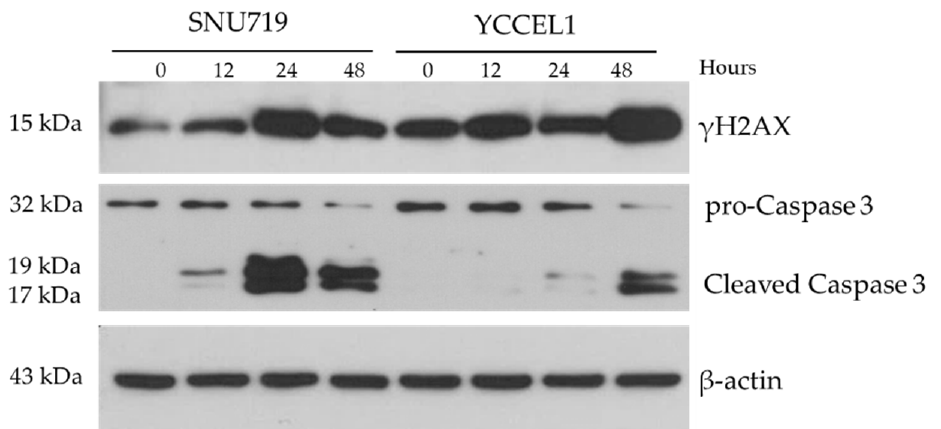
Figure 4. Protein Expression of γ H2A histone family member X ( γ H2AX) and caspase-3 after MC180295 treatment . The expression levels of γ H2AX and cleaved caspase-3 were up-regulated in both YCCEL1 and SNU719 cells treated with MC180295. 2.4. Expression of EBV Genes LMP1 and BZLF1 after MC180295 Treatment The mRNA expression levels of LMP1 and BZLF1 were increased by 1 µ M MC180295 in both the YCCEL1 and SNU719 cells (Figure 5).